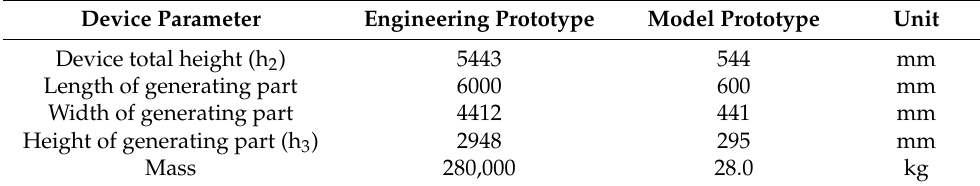
Figure 3. ( a ) Engineering prototype, ( b ) model prototype. Table 1. Engineering prototype and model prototype dimensions.